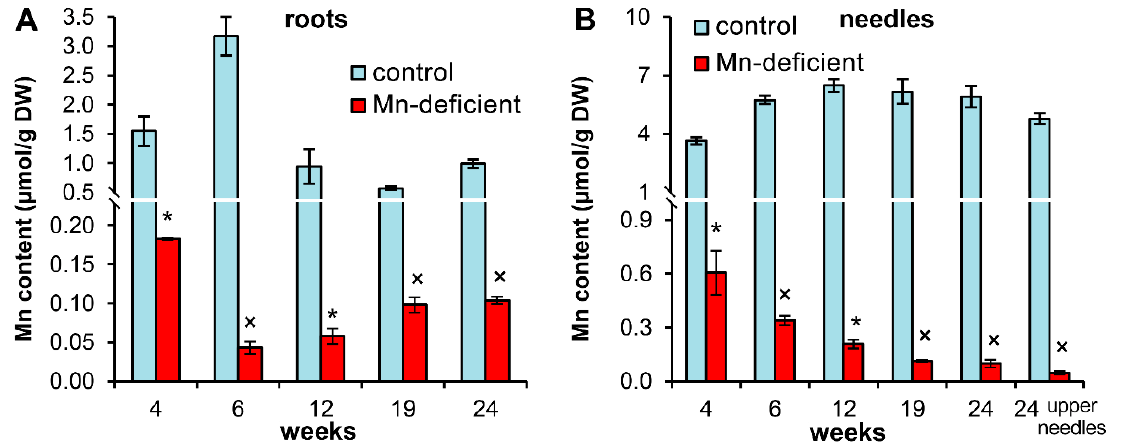
Figure 1. The Mn content in the organs of Scots pine seedlings: roots ( A ); and needles ( B ). The mean values ± SEs are given ( n = 6). Asterisks (*, for Student’s t test) or multiplication signs (×, for Mann–Whitney rank sum test) denote significant differences at p < 0.05 between control and Mn-deficient plants at each separate time point.